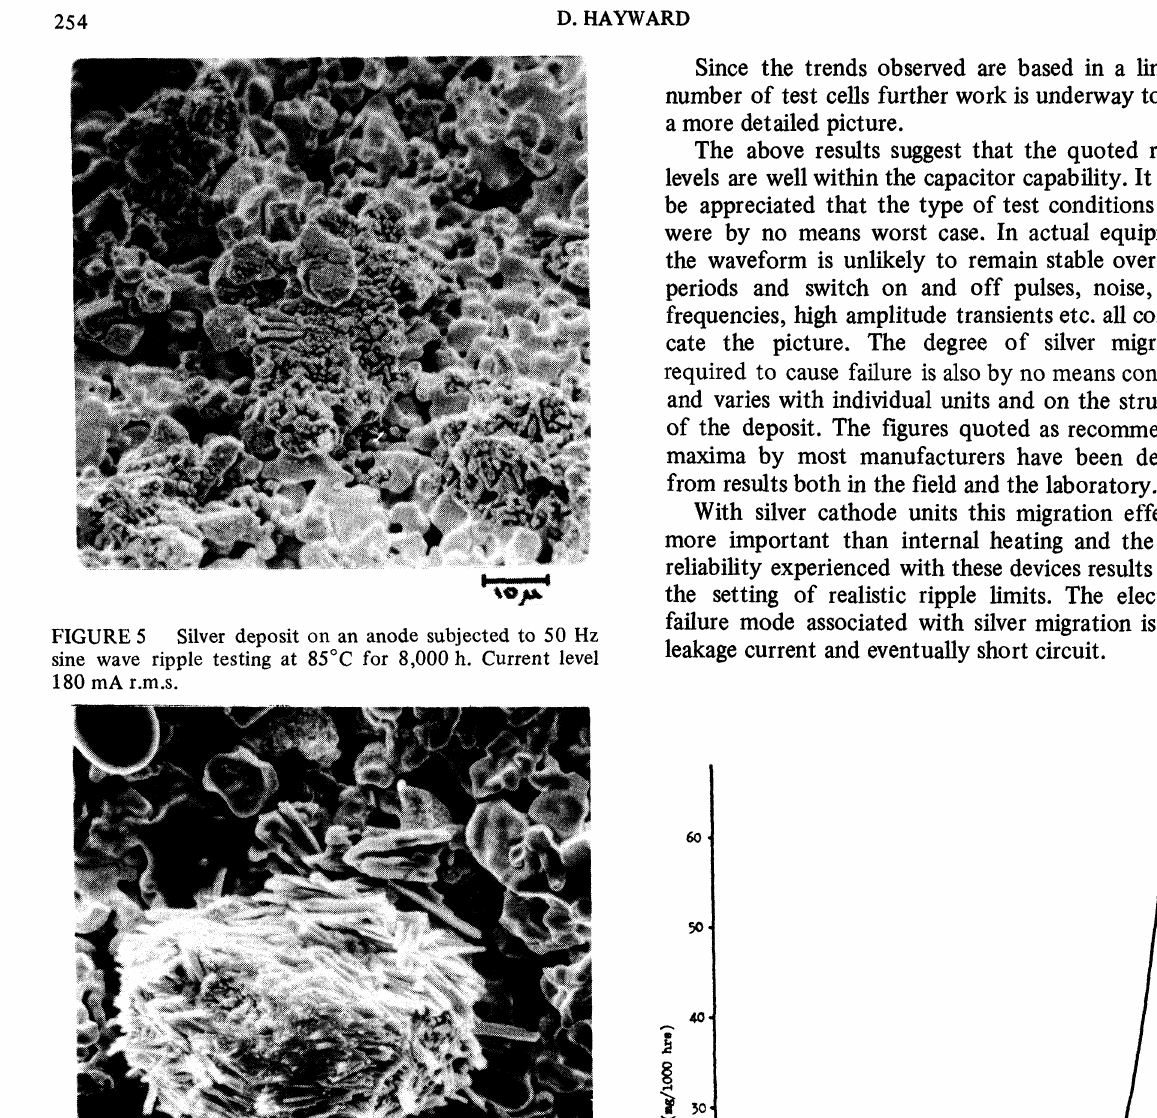
Loss of water vapour v. temperature for a